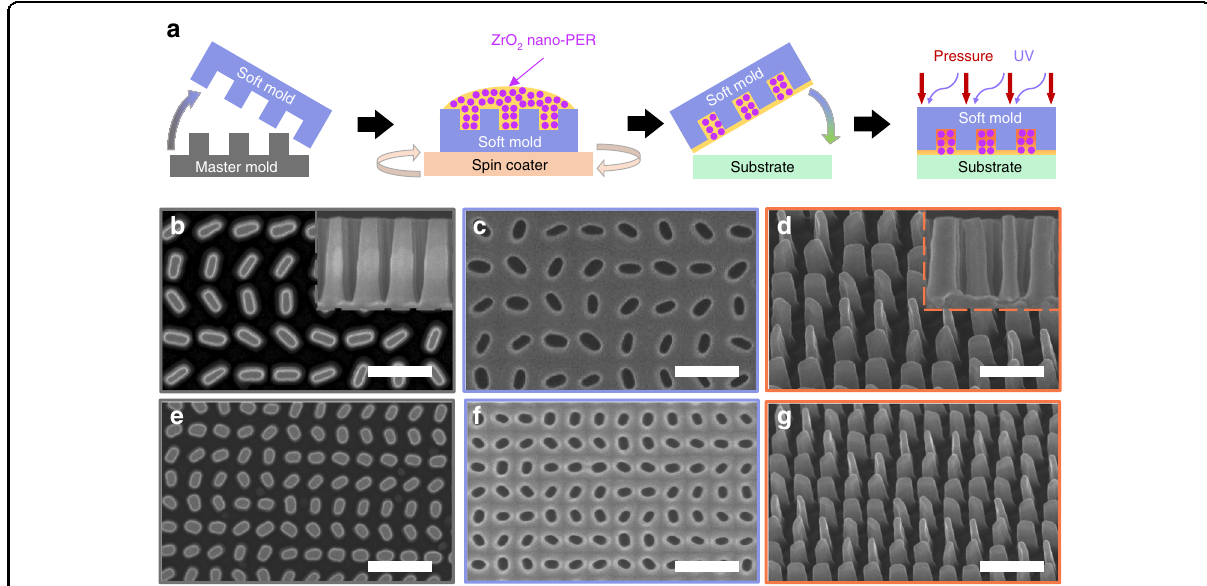
Fig. 3 Fabrication of UV metaholographic device using the one-step printable process of ZrO2 nano-PER. a Schematic of the one-step printable platform for fabrication of the UV metaholographic device. SEM images of b the master mold, c the soft mold, and d the one-step printed UV metasurface of the target hologram designed for λ = 325 nm. (Inset) cross-section view. SEM images of e the master mold, f the soft mold, and g the one-step printed UV metasurface of the target hologram designed for λ = 248 nm. All scale bars: 500